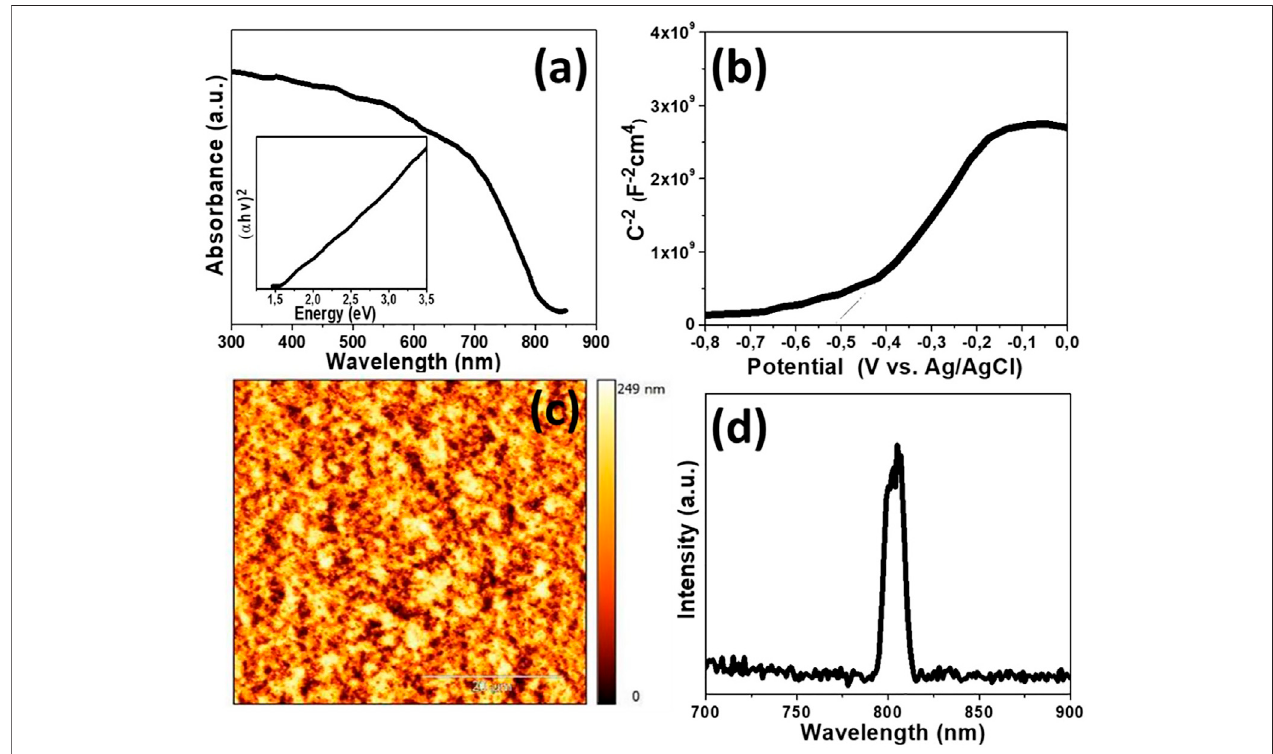
FIGURE3|(A) UV-Vis/NIRabsorptionspectrumofFeMnO 3 NPs[Inset:the(Fhv) 2 versushvplotderivedfromopticalabsorptionspectra]. (B) Mott-Schottkyplotof the inverse square space-charge capacitance (1/C SC2 ) as a function of applied voltage (E) relative to the redox potential of Ag/AgCl (3 M KCl) for the FeMnO 3 NPs. (C) Typical AFM image of the ITO/FeMnO 3 fi lm after SCS synthesis at 450 ° C (The scale bar is 20 μ m). (D) Room-temperature PL emission spectra of the FeMnO 3 NPs.